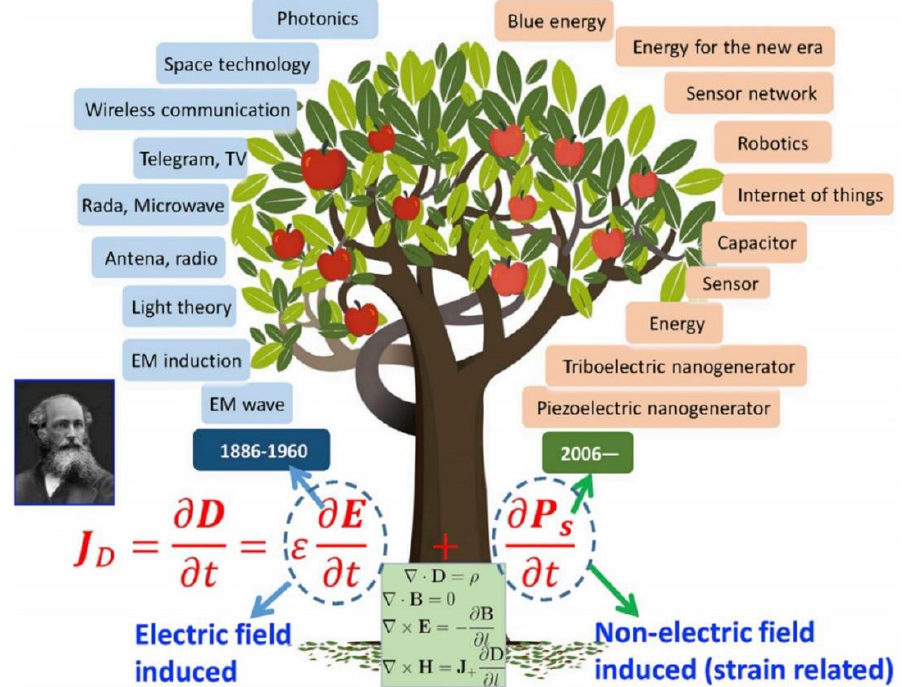
Figure 2. A tree idea to illustrate the newly revised Maxwell’s displacement current: the first term 𝜀 𝜕𝐸 is responsible for the electromagnetic (EM) waves theory; and the newly added term 𝜕𝑃 𝑆 𝜕𝑡 applications of Maxwell’s Equations in energy and sensors, which are the nanogenerators (NGs). Reproduced with permission [21]. Copyright 2020,